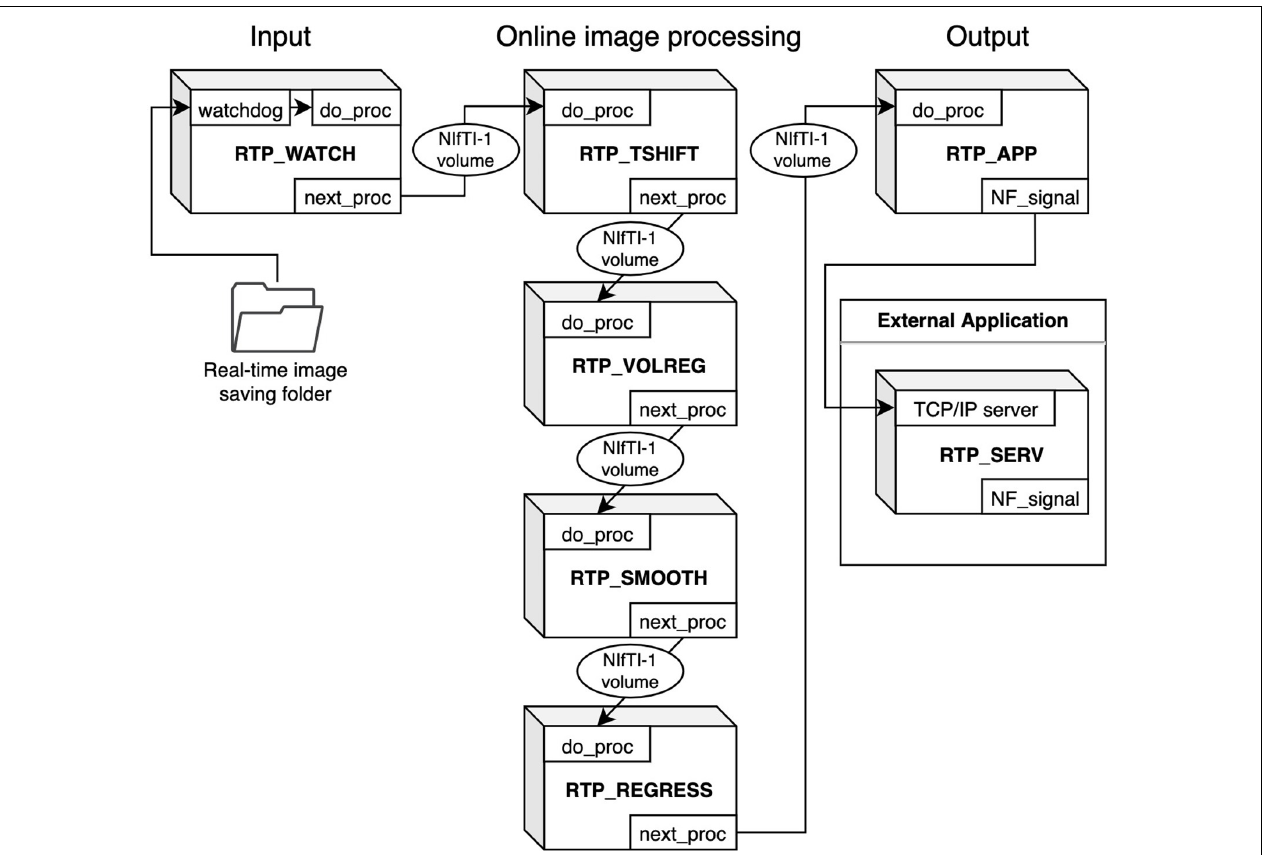
FIGURE 1 | Overview of the RTPSpy module design for creating an online fMRI processing pipeline. RTP_WATCH is the entrance module, and RTP_APP is the terminal module of a pipeline. Other modules have common input and output interfaces. They can be connected in any combination and order. The modules